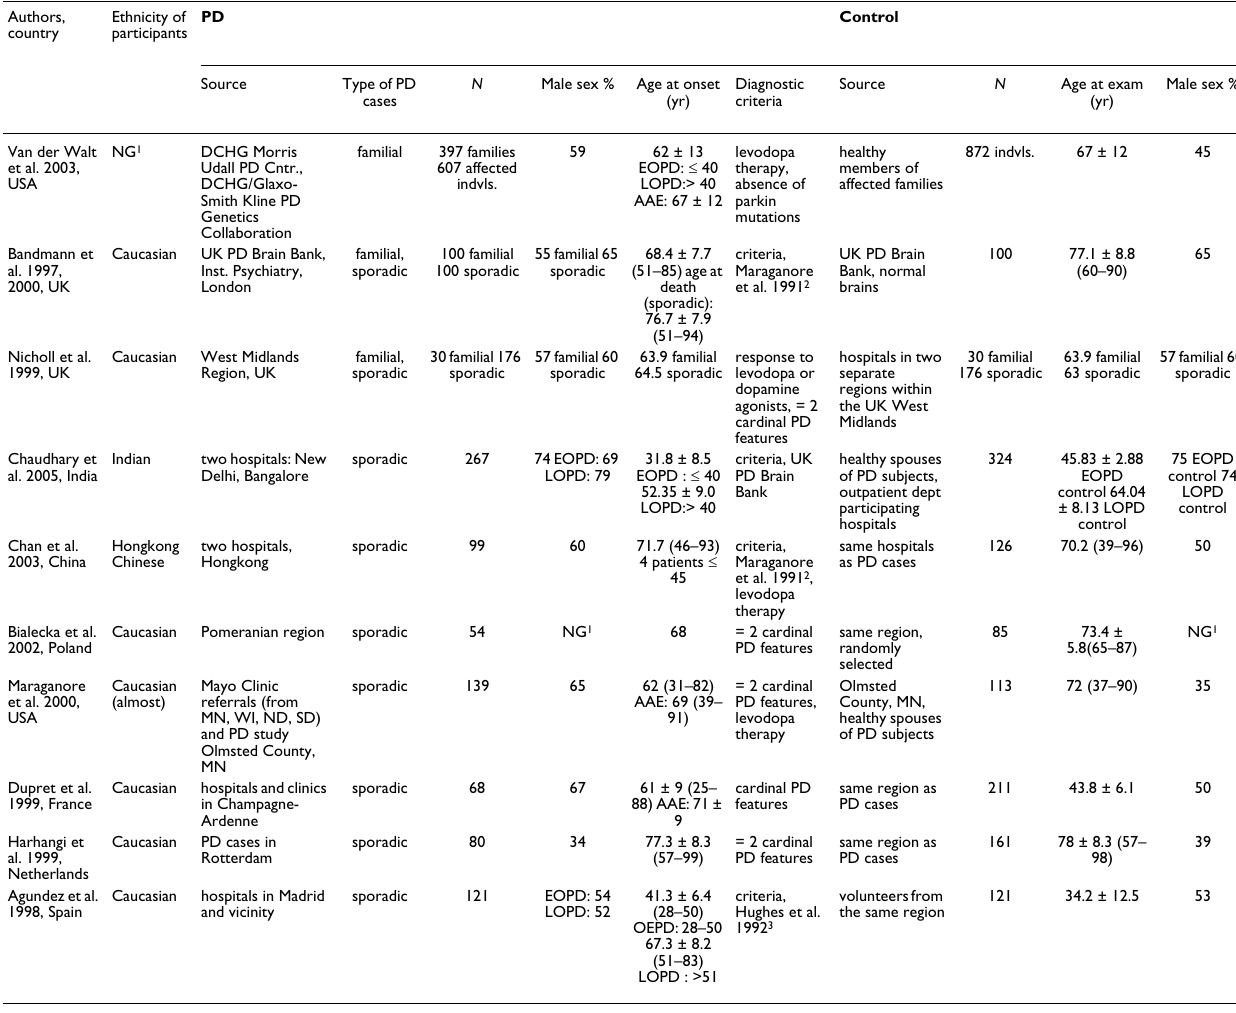
Table 3: Characteristics of studies on NAT2 polymorphisms and Parkinson's disease: patients and control subjects Authors,